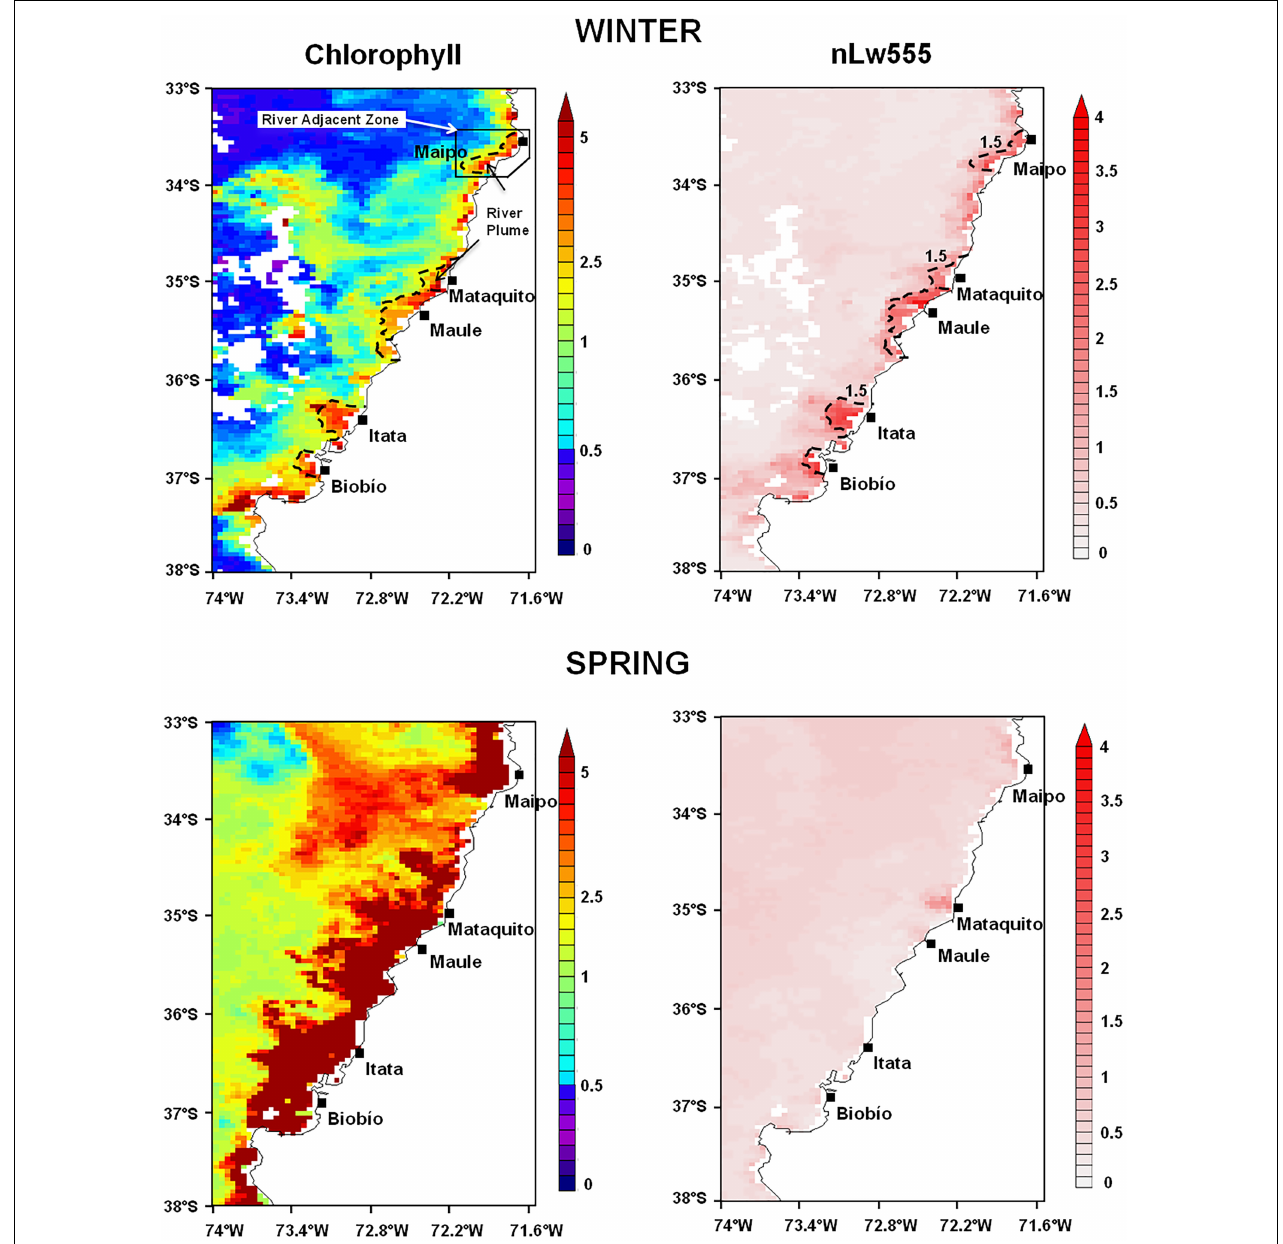
FIGURE 2 | Satellite-derived Chlorophyll (mg m − 3 ) and nLw555 (mW cm − 2 µ m − 1 sr − 1 ) conditions observed during winter (13–20 August 2008) and spring (16–23 November 2008) along the coastal area off Central Chile. Black dashed line indicates the winter river plume boundaries (nLw555 > 1.5 mW cm − 2 µ m − 1 sr − 1 ) detected in the adjacent coastal